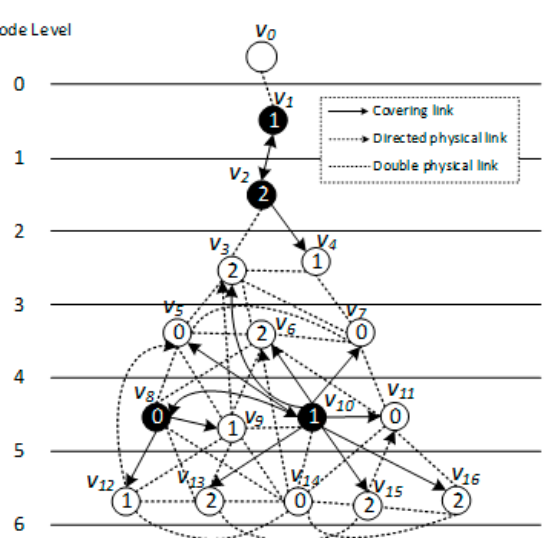
Figure 13. Minimum covering node set for ABRCD.